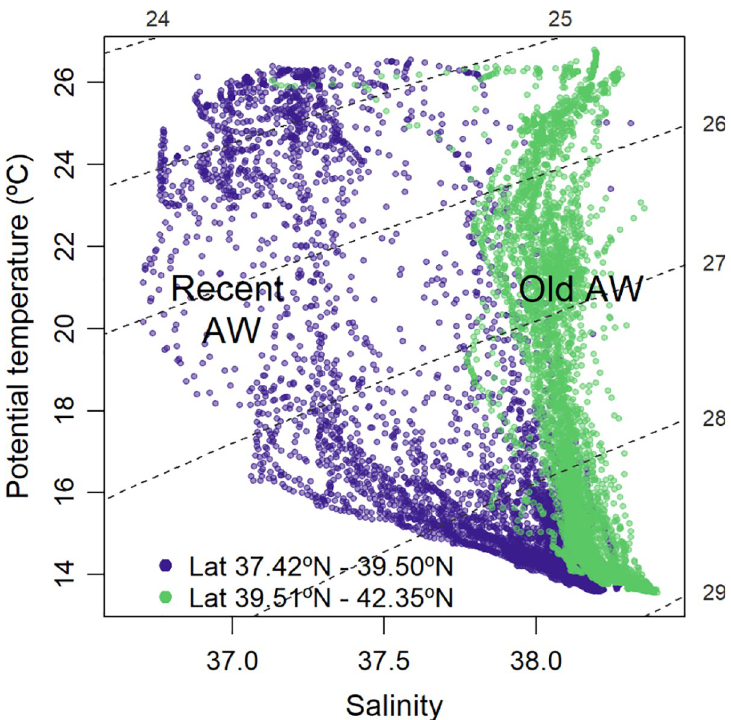
Fig 2. TS diagram of the water layer from 0 to 100 m depth. Recent Atlantic Water (blue dots), south of 39.5˚N; old Atlantic Water (green dots), north of 39.5˚N.